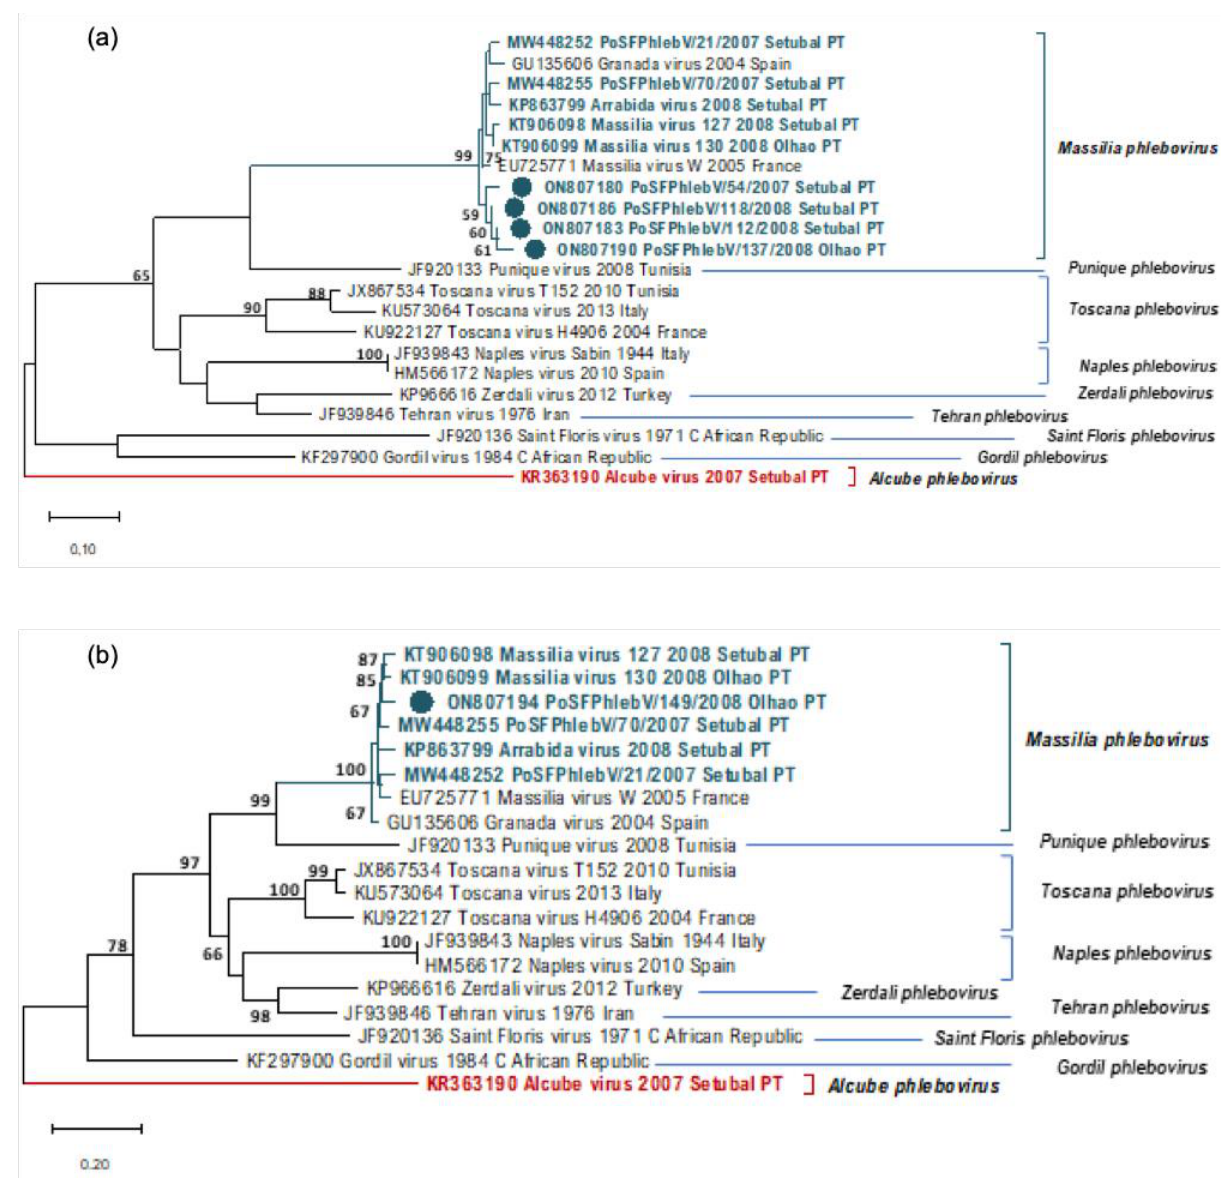
Figure 3. Maximum likelihood phylogenetic trees of phleboviruses partial RNA-dependent RNA polymerase nucleotide sequences (segment L). Sequence names in blue ( Massilia phlebovirus ) and in red ( Alcube phlebovirus ) were detected in Portugal (PT). Sequence names marked with a colored bullet have been sequenced in this study. Bootstrap support over 60% is presented on branches. Names of the sequences in the tree match the IDs in the alignment made available as a Supplementary